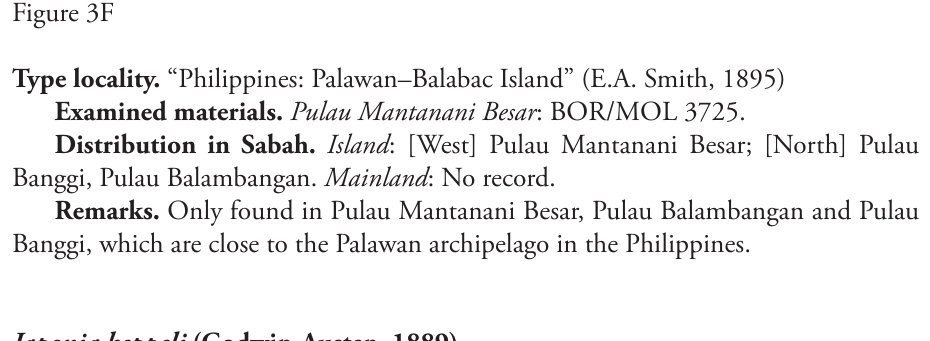
Type locality. “Malaysia: Sarawak: Miri–Batu Niah N.P” (Godwin-Austen, 1889) Examined materials. Pulau Gaya : BOR/MOL 6681, BOR/MOL 6683, BOR/ MOL 8466, BOR/MOL 8481, BOR/MOL 8489, BOR/MOL 8494, BOR/MOL 8501, BOR/MOL 10363, BOR/MOL 10368. Pulau Sapi : BOR/MOL 10027, BOR/ MOL 10293. Pulau Manukan : BOR/MOL 10298, BOR/MOL 10302, BOR/MOL 10303, BOR/MOL 10307, BOR/MOL 10316, BOR/MOL 10318, BOR/MOL 10324. Pulau Sulug : BOR/MOL 10330, BOR/MOL 10332, BOR/MOL 10333, BOR/MOL 10339, BOR/MOL